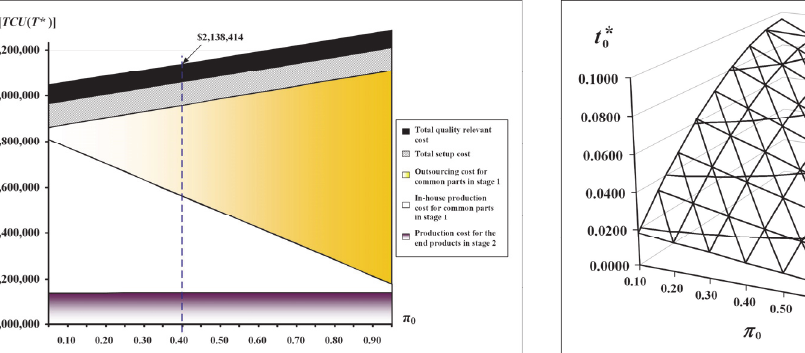
Fig. 9. The behavior of cost contributors to E [ TCU ( T *)] in relation to π 0